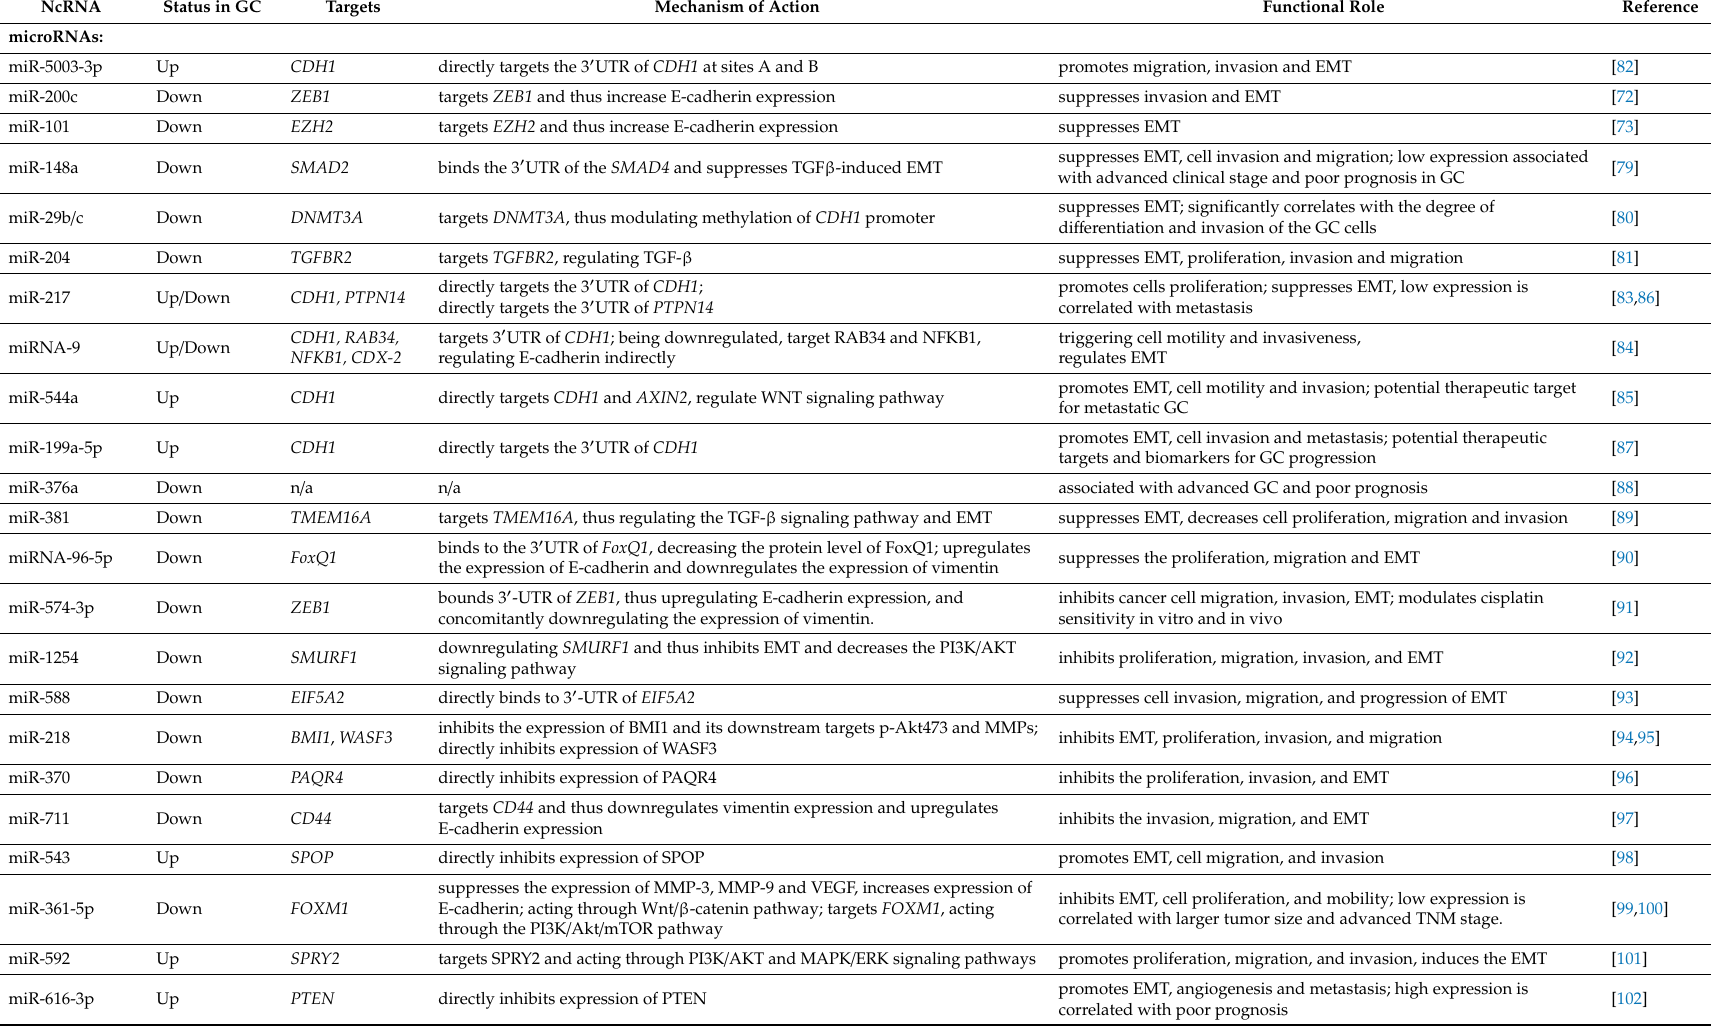
Table 1. Non-coding (Nc)RNAs, participating in EMT regulation in